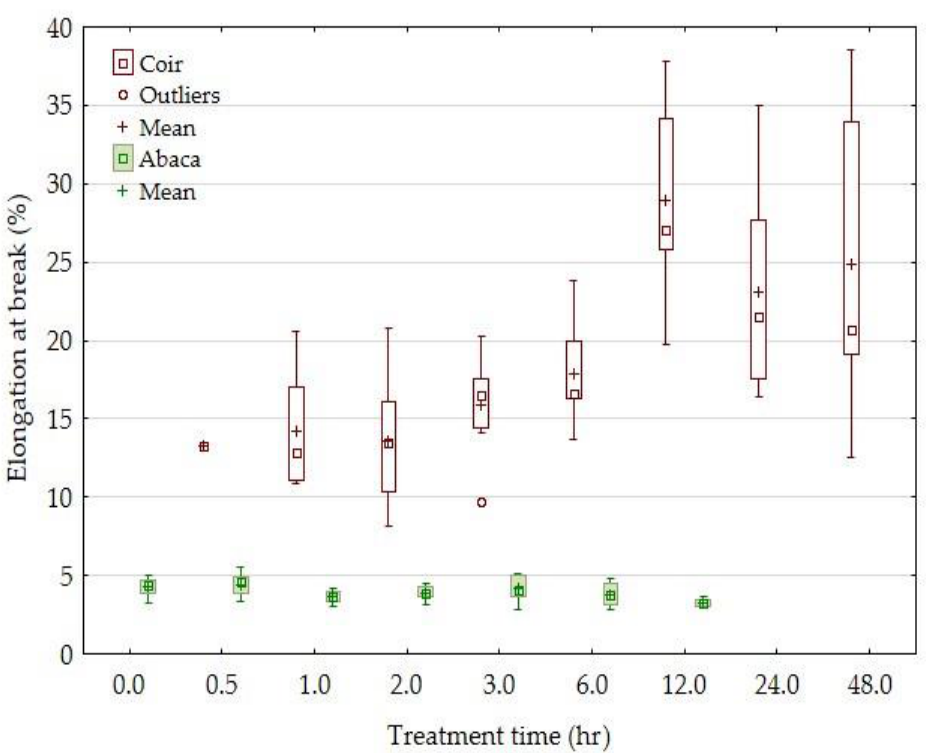
Figure 5. The dependence of the elongation at break of the coir and abaca fibers on the time of treatment in a 5% solution of NaOH. Table 1. Statistical evaluation of static tensile test according to the ANOVA F-test with stated parameter p at significance level α = 0.05 at a change in the alkali treatment time in the 5% solution of NaOH. Fiber